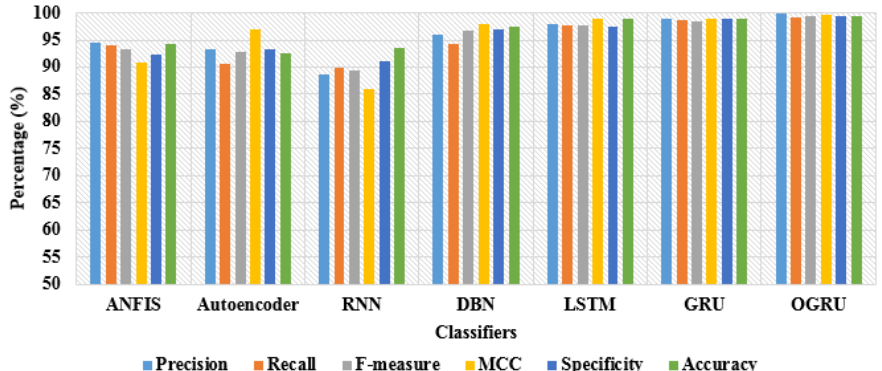
Figure 8. Graphical comparison of dissimilar classifiers with 80% training and 20% testing of data.